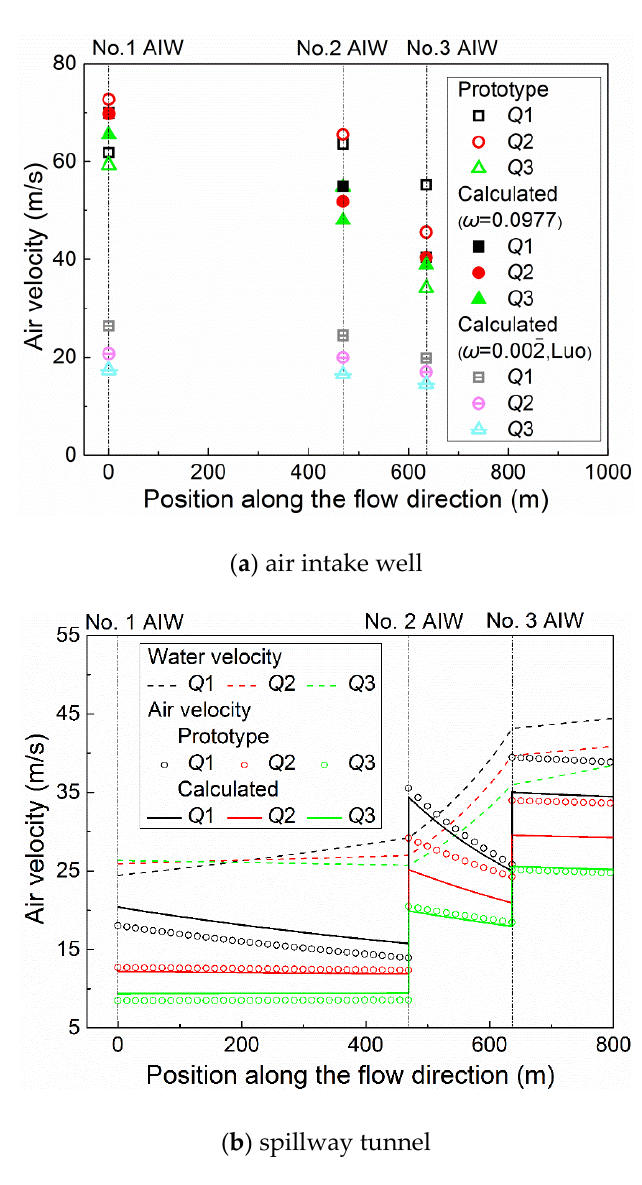
Figure 7. Comparison of the actual and the theoretical air velocities. ( a ) Air intake well and ( b ) spillway tunnel.